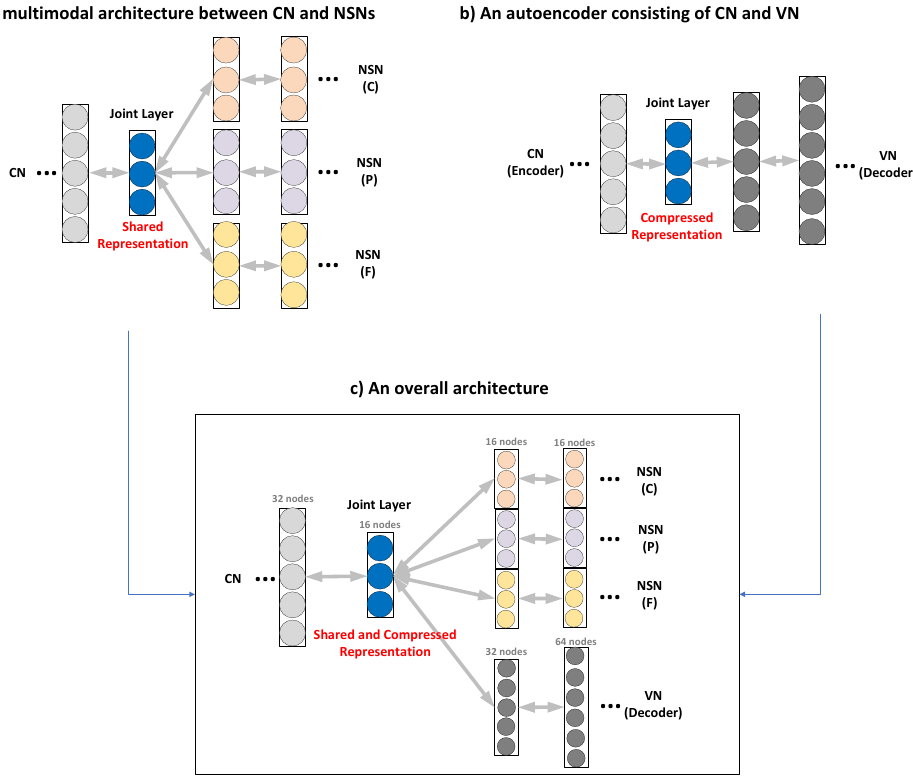
Figure 2. Building blocks of the proposed system: ( a ) a multimodal architecture between CN (common network) and NSN s (nutrient-specific networks), ( b ) an autoencoder consisting of CN and VN (verification network), and ( c ) an overall